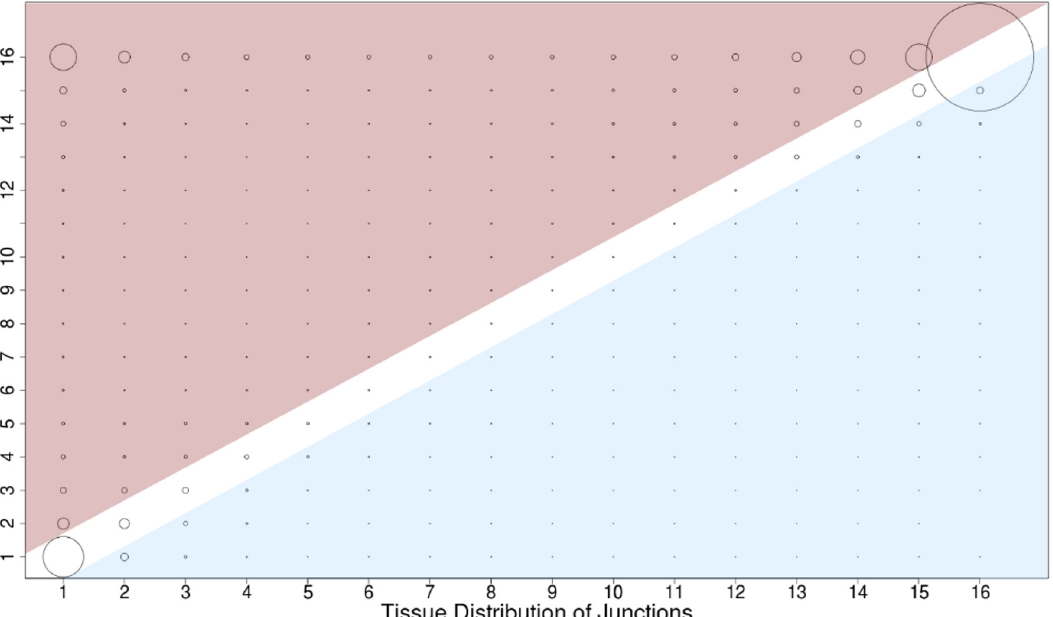
Fig 4. Gene and splice junction expression relations. Splice junctions from paired-end data have been assigned to genes and filtered for expression in tissues. Circle size depicts the number of junction-gene pairs. Plotted on the x-axis is the number of tissues a splice junction is found in and plotted on the y- axis is the number of tissues the corresponding gene is found in. Red regions indicated the gene is expressed in more tissues than the junction. Blue regions indicate the junction is found in more tissues than the gene, a rare event but possible due to threshold based analyses. Circles with a center in neither the blue or red region have their genes and junctions present in an equal number of tissues.